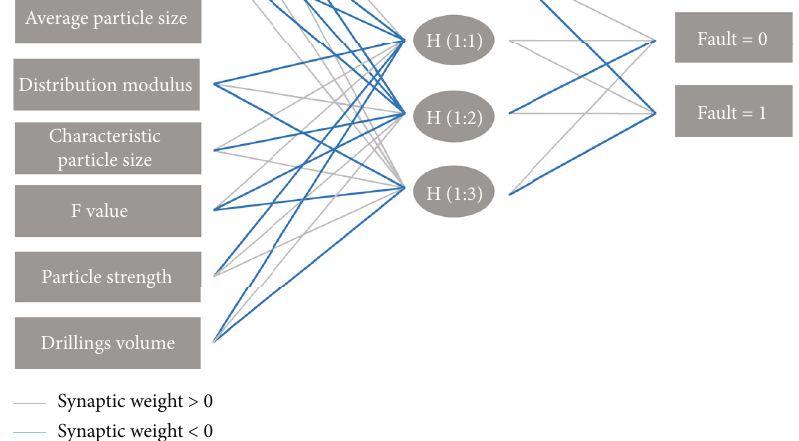
Figure 11: Neural network structure.